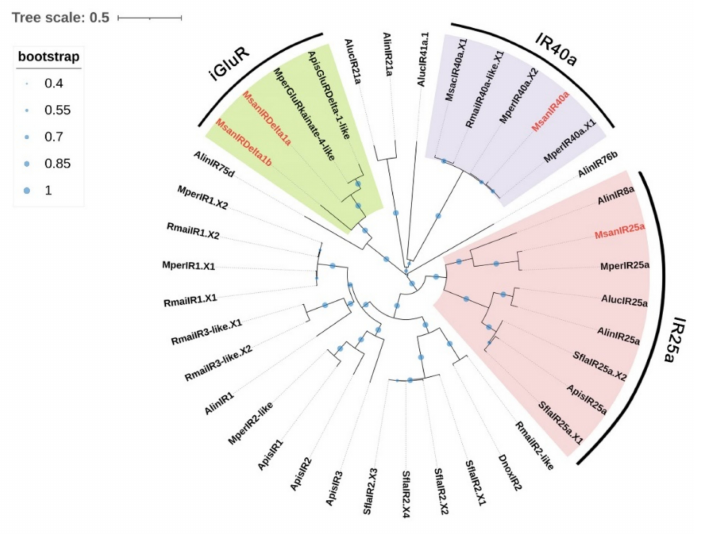
Figure 6. Phylogenetic tree of 39 ionotropic receptors (IRs) from 9 Hemiptera species. The phylo- genetic tree of Hemiptera IRs was built using 39 IR sequences from seven different aphid species (6 from Si. flava ; 5 from Ac. pisum ; 7 from My. persicae ; 1 from D. noxia ; 6 from R. maidis ; 1 from Melanaphis sacchari ; 4 from M. sanborni ) and two plant bugs (6 from Ad. lineolatus ; 3 from Ap. lucorum